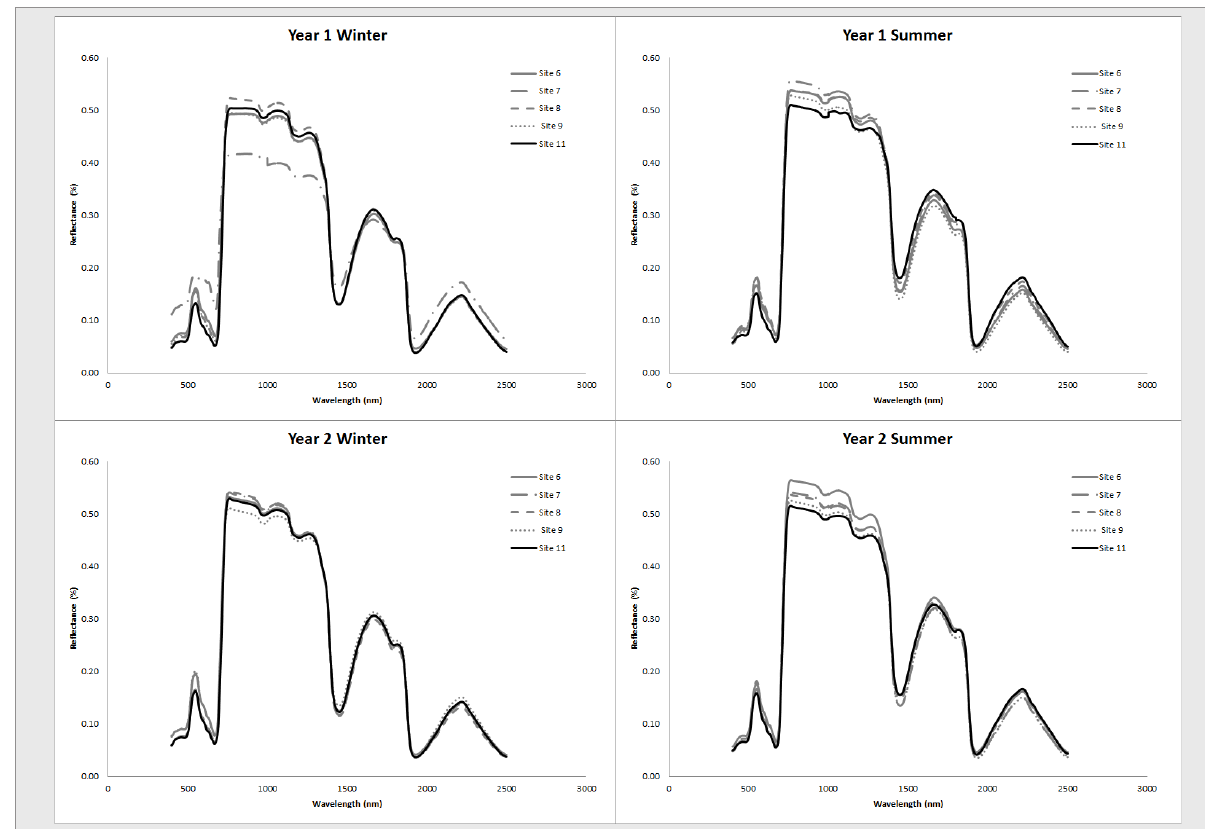
Figure 5: Average reflectance (%) of green leaves per sampling site for both seasons and years. Only a single new growth green leaf was available on the day of sampling for Site 7 in winter of Year